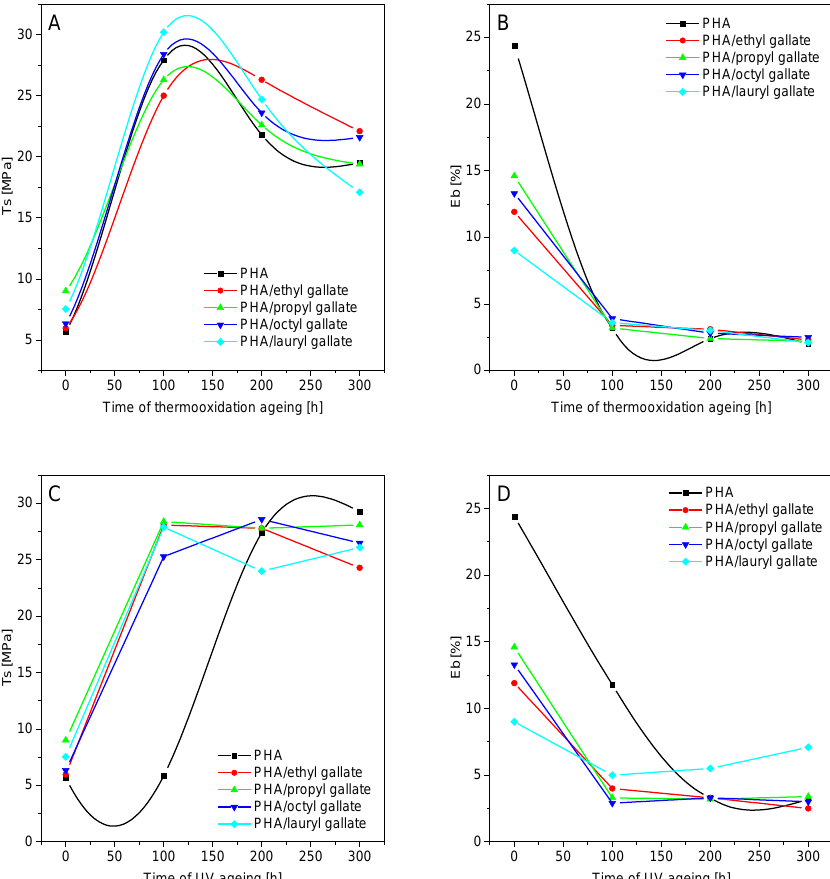
Figure 8. Changes in PHA mechanical properties before and after thermooxidation ( A , B ) and UV aging ( C , D ).